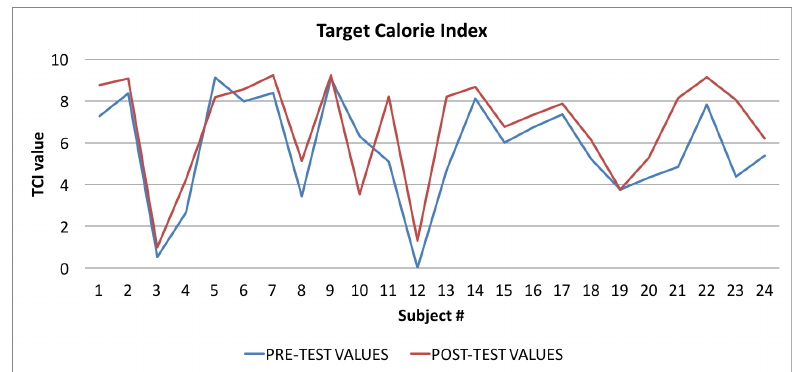
Figure 10. Target Calorie Index: averages of the values calculated at the beginning (blue line) and at the end of the trial (red line).